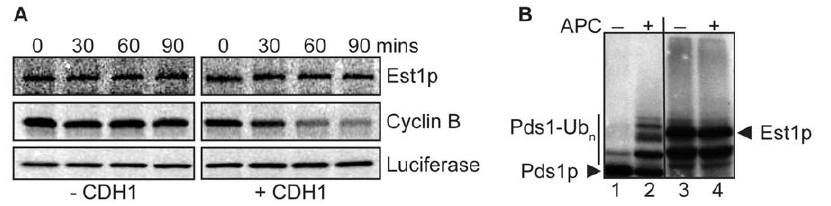
Figure 5. Est1p is not a target of the APC invitro. (A) Est1p is not degraded by the APC in vitro . X. laevis egg extract ( 2 CDH1) was activated by the addition of in vitro transcribed human Cdh1 to obtain APC-activated extract ( + CDH1). 35 S-labeled substrate proteins ( S. cerevisiae Est1p, D. melanogaster Cyclin B, or firefly luciferase) were incubated with either inactive ( 2 CDH1) or activated extract ( + CDH1) as described in Materials and Methods. Samples were removed at the indicated times, separated by gel-electrophoresis and exposed to a phosphor-imager screen. (B) Est1p is not ubiquitinated in vitro . 35 S-labeled substrates ( S. cerevisiae Est1p and Pds1p) were incubated with Ubc4p (E2 ligase), recombinant S. cerevisiae Cdh1p, and methylated-ubiquitin in the absence ( 2 ; lanes 1 and 3) or presence ( + ; lanes 2 and 4) of purified S. cerevisiae APC complexes. Reactions were separated by gel electrophoresis and detected by autoradiography film. Black arrows indicate the unmodified protein. The vertical line indicates the region where ubiquitin-conjugated forms of Pds1p migrate.